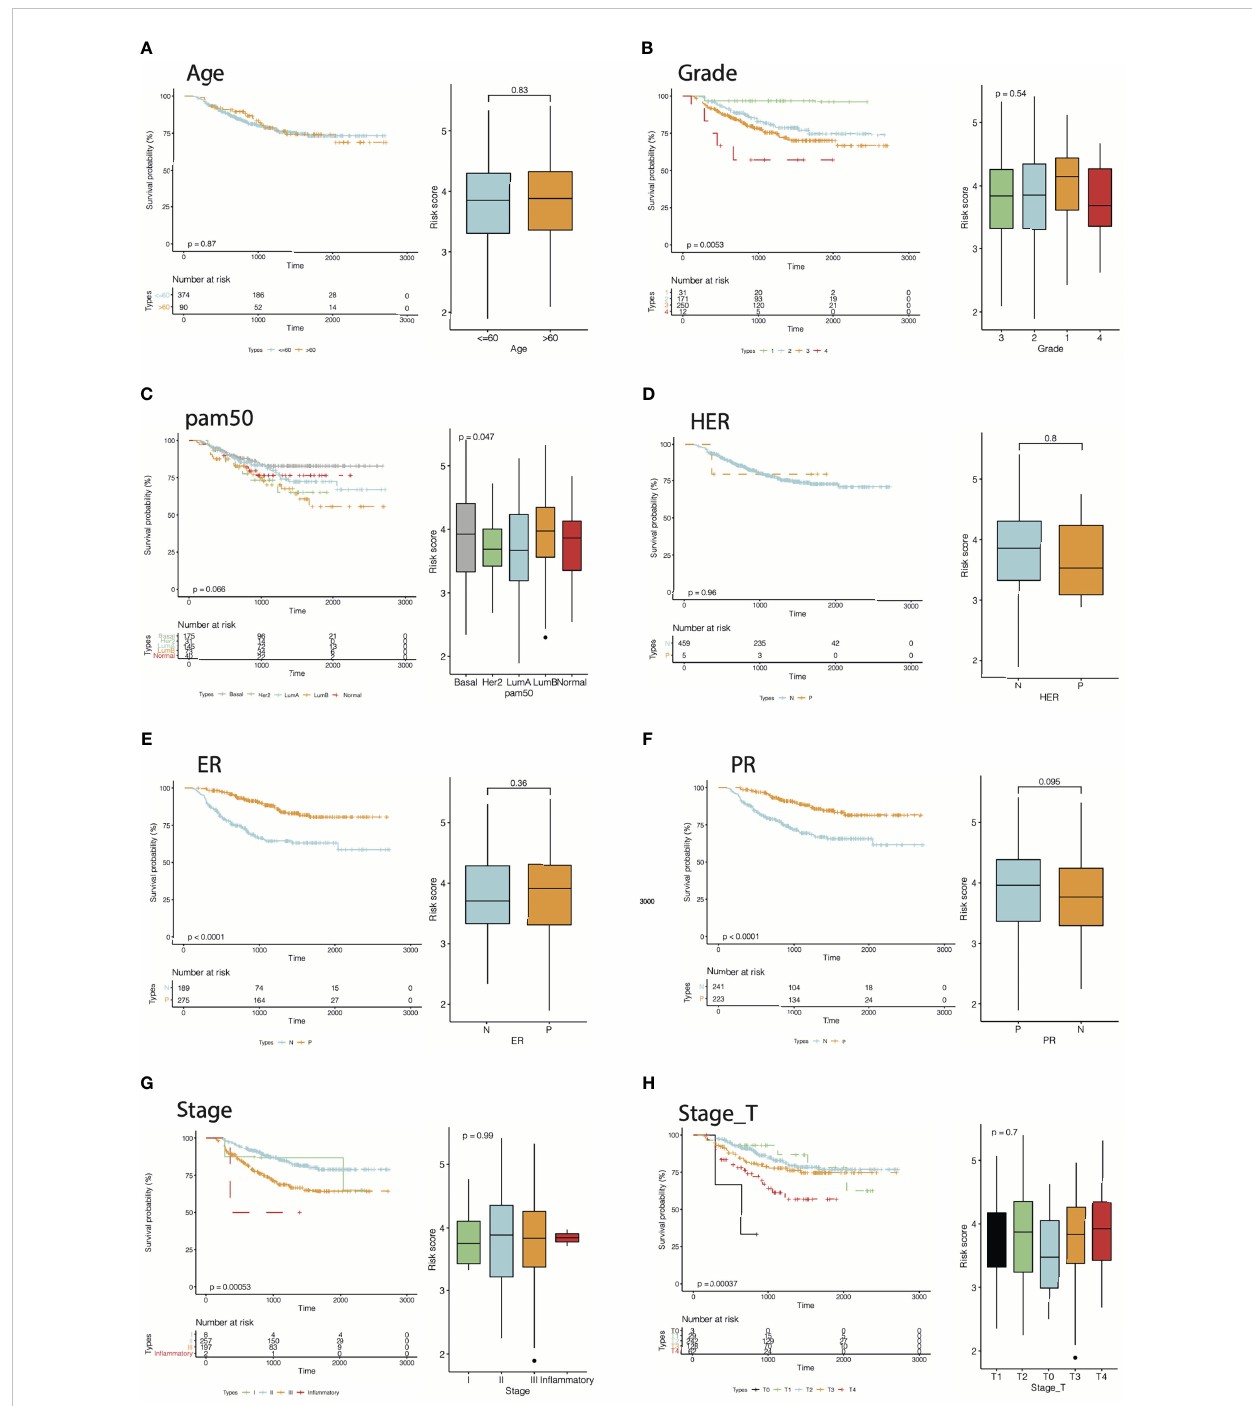
FIGURE 8 Energy ef fi ciency and stability assessment of cr-TILCD8TSig scoring models. Prognostic signi fi cance of cf-TILCD8TSig in GSE25066 cohort strati fi ed by age (A) , grade (B) , pam50 (C) , HER (D) , ER (E) , PR (F) , stage (G) , and stage_T (H)